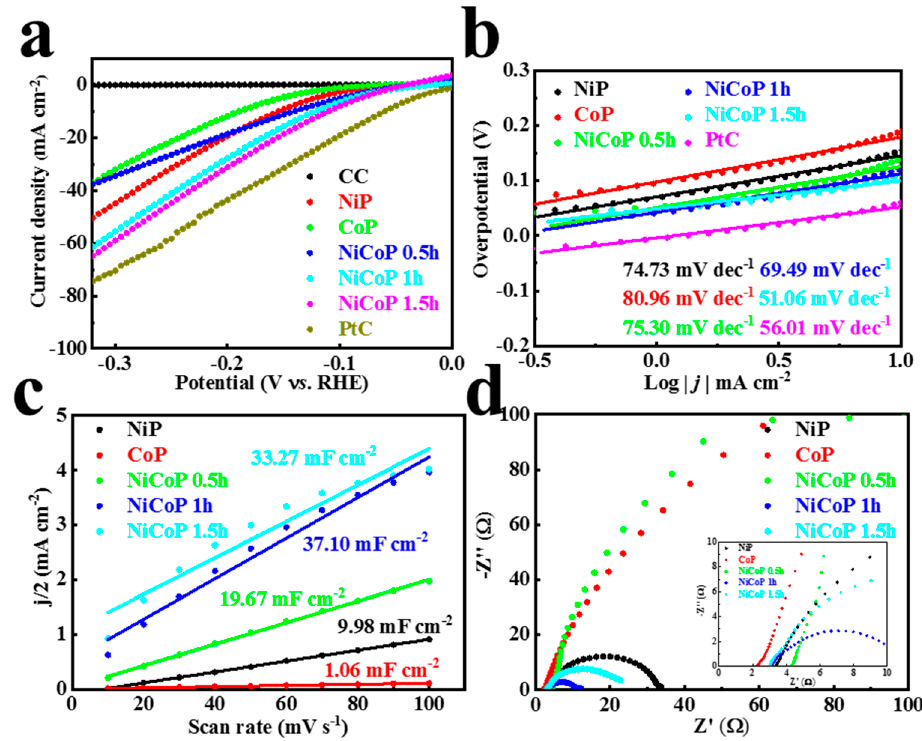
Figure 4. ( a ) LSV curves and ( b ) Tafel plots of CC, NiP, CoP, NiCoP 0.5 − 1.5 h, and PtC. ( c ) C dl and ( d ) EIS Nyquist plot of NiP, CoP, and NiCoP 0.5 − 1.5 h in 0.5 M H 2 SO 4 for HER; the inset presents the plot enlarged over the high frequency range.